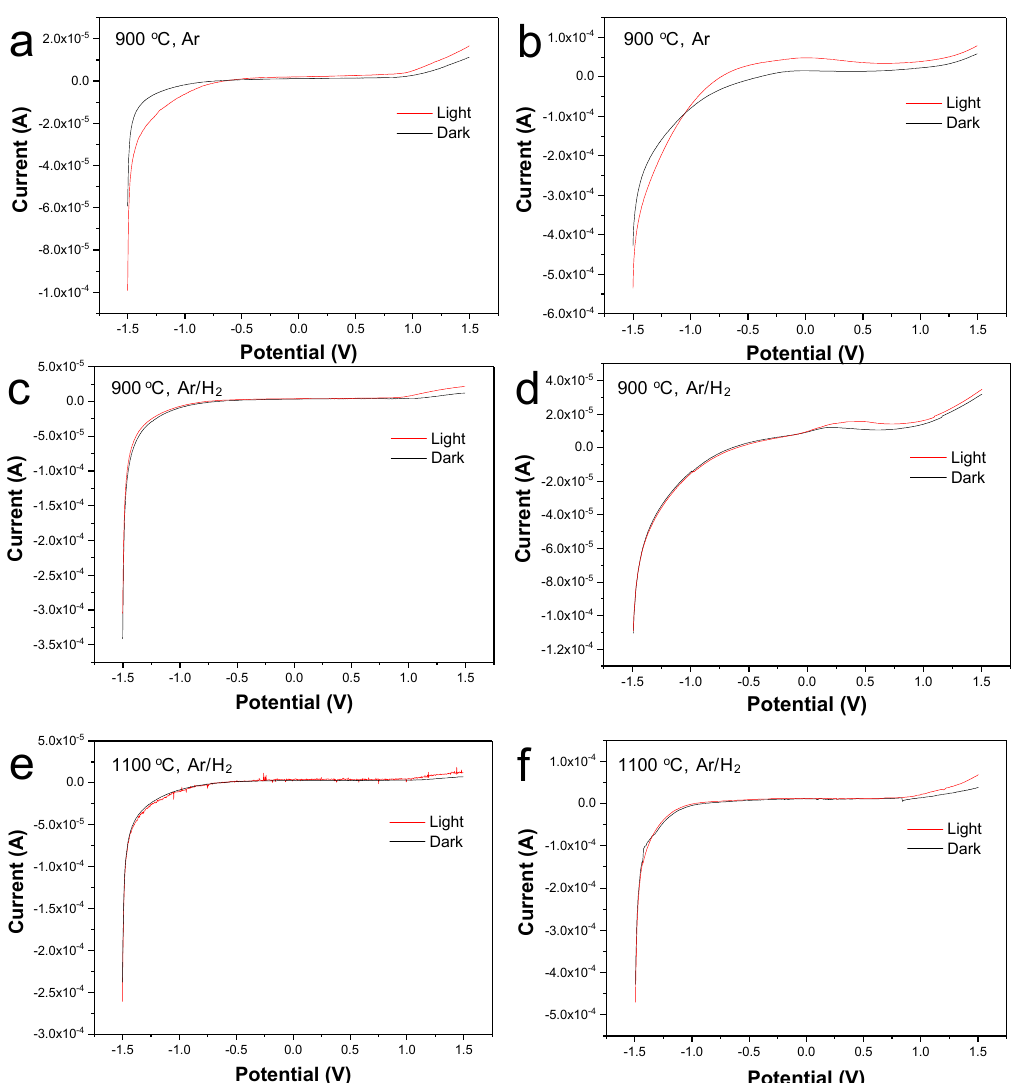
Figure 7. Line-sweep voltammogram (LSV) curves measured at a scan rate of 50 mV / s in darkness or under LED illumination from the electrodes made of (N)G prepared at 900 ◦ C under Ar ( a ) or Ar / H 2 ( c ), at 1100 ◦ C under Ar / H 2 ( e ) or G prepared at 900 ◦ C under Ar ( b ) or Ar / H 2 ( d ), at 1100 ◦ C under Ar / H 2 ( f ), respectively.